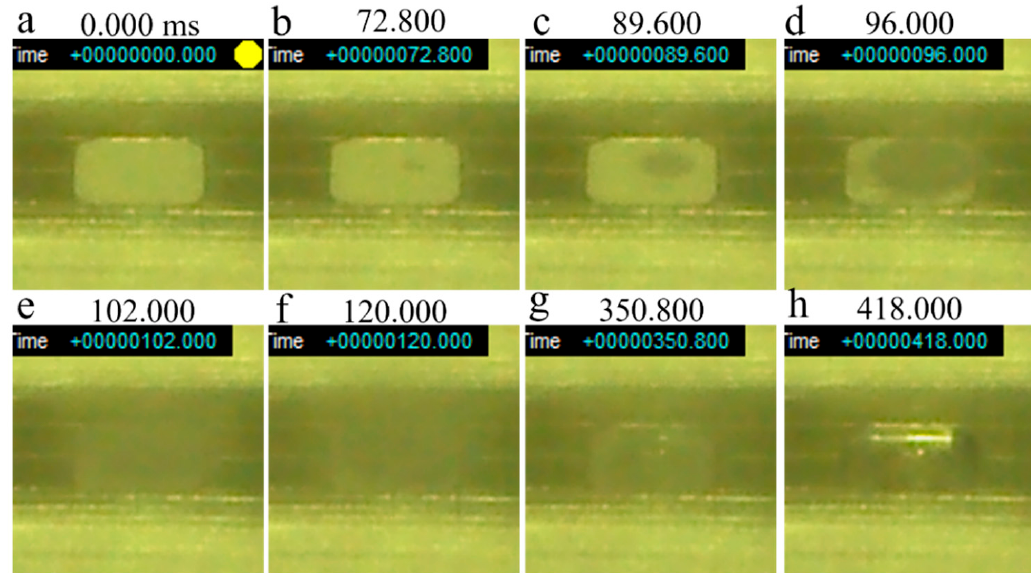
Figure 13. Series of snapshots of a smoke test performed on virgin Inconel 718 alloy PA powder without preheating: ( a ) 0 ms; ( b ) 72.8 ms; ( c ) 89.6 ms; ( d ) 96 ms; ( e ) 102 ms; ( f ) 120 ms; ( g ) 350.8 ms; ( h ) 418 ms. Beam irradiation pulse frequency ( f 1 ): 100 Hz; Beam dwell time (1/ f 2 ): 0.1 ms; Beam current ( I ): 20 mA; Beam diameter: 1.8 mm.